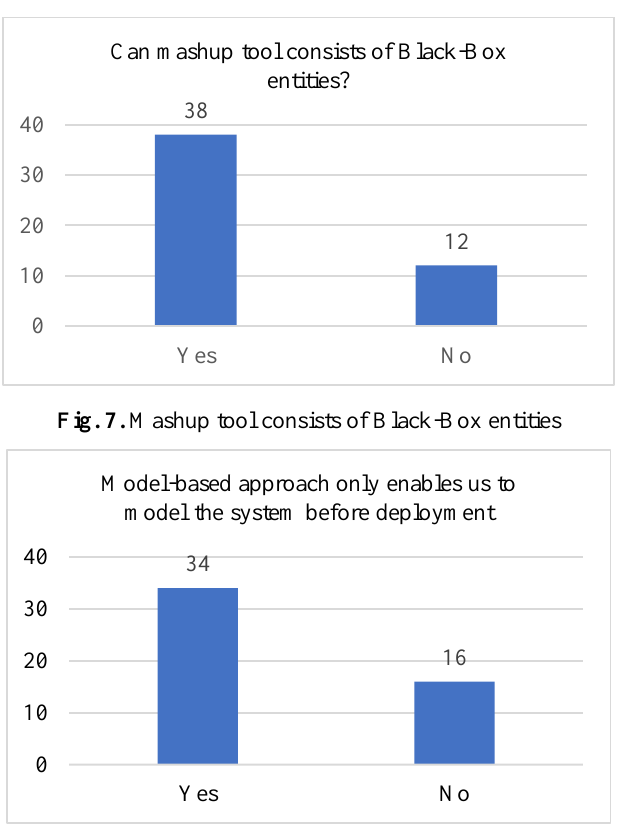
Fig. 8. Enabling to model the system before deployment